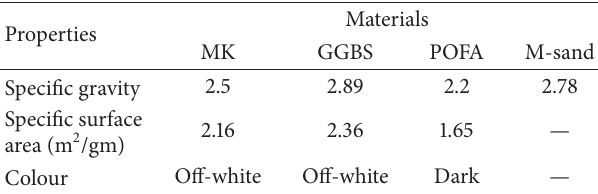
Table 2: Materials physical